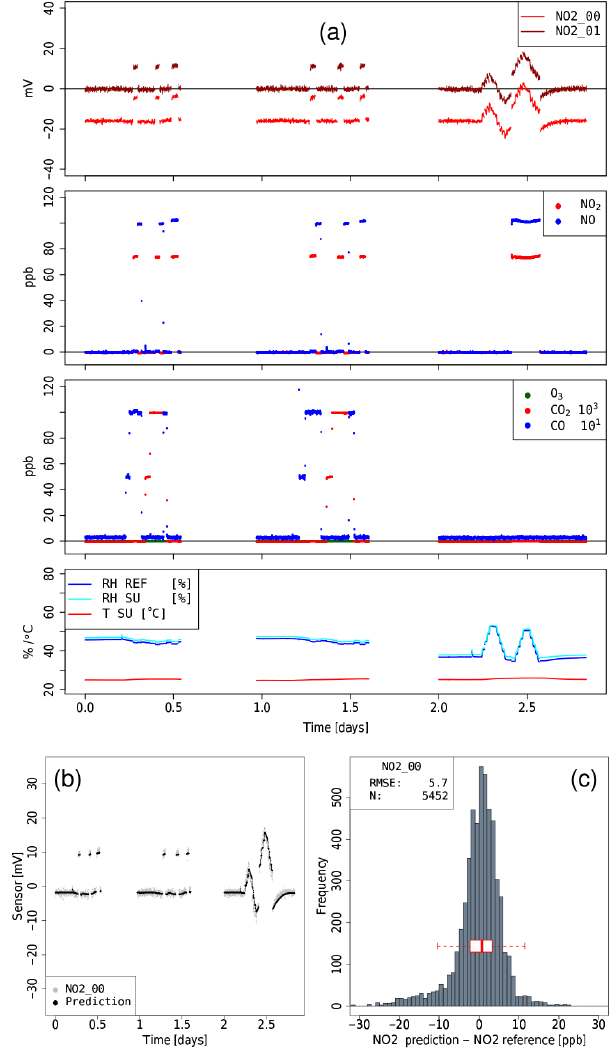
Figure 2. (a) Time series of sensor signals (NO2_00/NO2_01) (mV), gas concentrations (ppb), temperature ( ◦ C) and relative hu- midity (%). Time is indicated in days. The gaps between the three parts may last longer than depicted. CO concentration is scaled by a factor 10, CO 2 concentration is scaled by a factor 10000 to en- hance the clarity of the figure. Note that O 3 concentration is con- stant at 0ppb in this series. (b) Measured and predicted sensor sig- (cid:54)= 0, α D (cid:54)= 0 and α i = 0; mean sensor value nal (Eq. 1 with α NO RH 2 subtracted). (c) Histogram of differences between NO 2 predictions (Eq. 1 as specified in b , solved for NO 2 ) and measurements of the reference